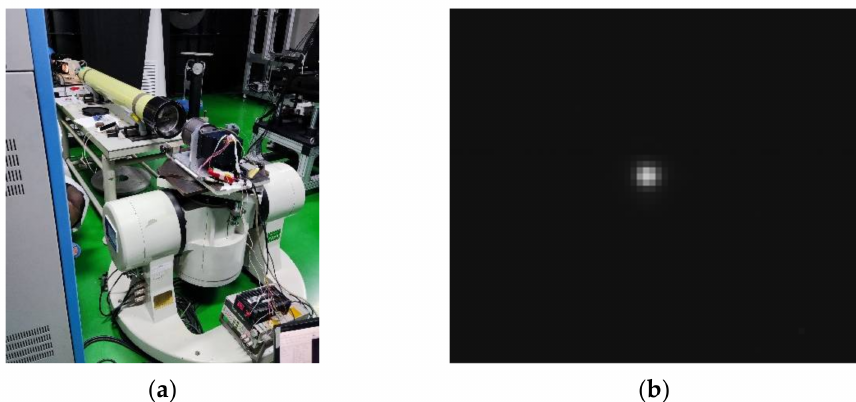
Figure 13. The images of the interior orientation element calibration experiment: ( a ) the real scene; ( b ) the star-point